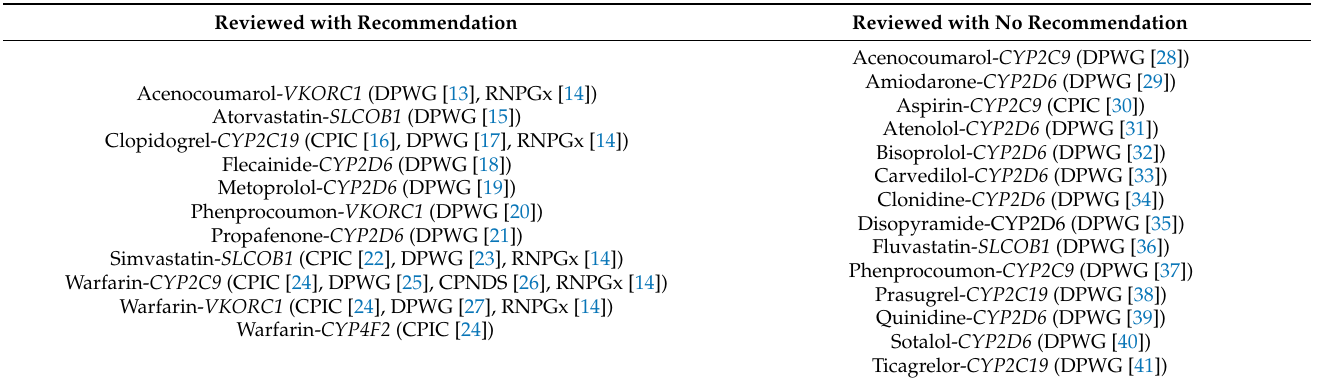
Table 1. Cardiovascular drug-gene pairs reviewed in main pharmacogenetic guidelines. Reviewed with